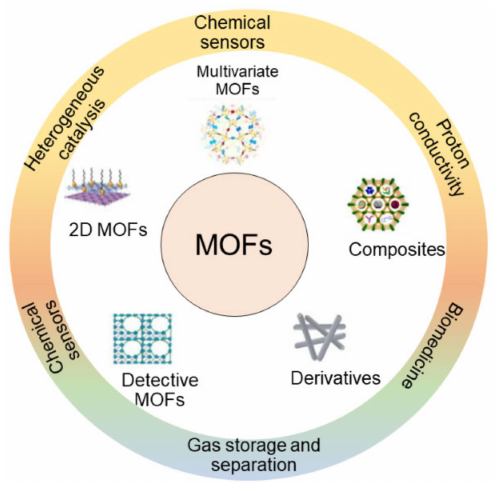
Figure 5. Schematic illustration of MOFs structure and functional applications (adapted from Jiao et al., 2019